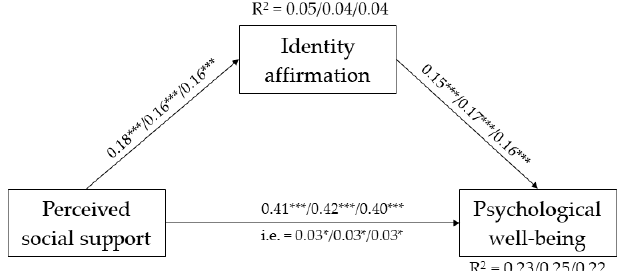
Figure 3. Multiple group mediation model for age cohorts. Standardized path coefficients are re ‐ ported (young adults/early adults/middle adults). * p < 0.05 *** p < 0.001. Gender identity groups are not included in the figure for the sick of simplicity.